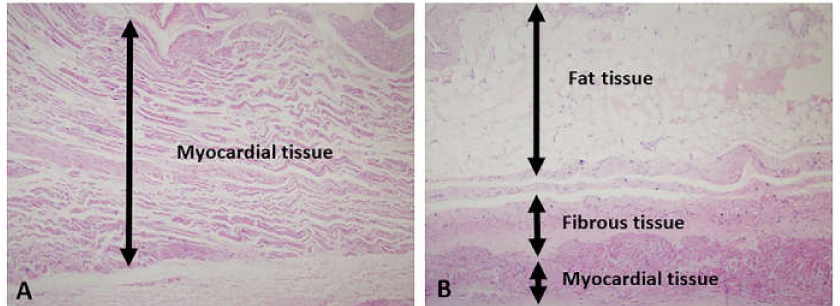
Figure 1. Hematoxylin and eosin staining of the left atrial tissue (( A ) adipose tissue component <10%; ( B ) adipose tissue component ≥